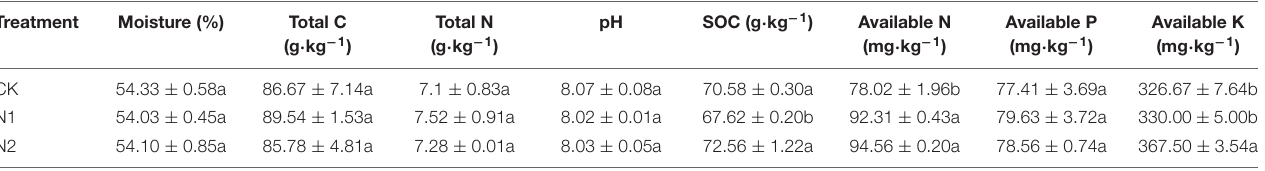
FIGURE 2 | Layout diagram of field block design experiments. TABLE 1 | Effects of N application on soil chemical properties.